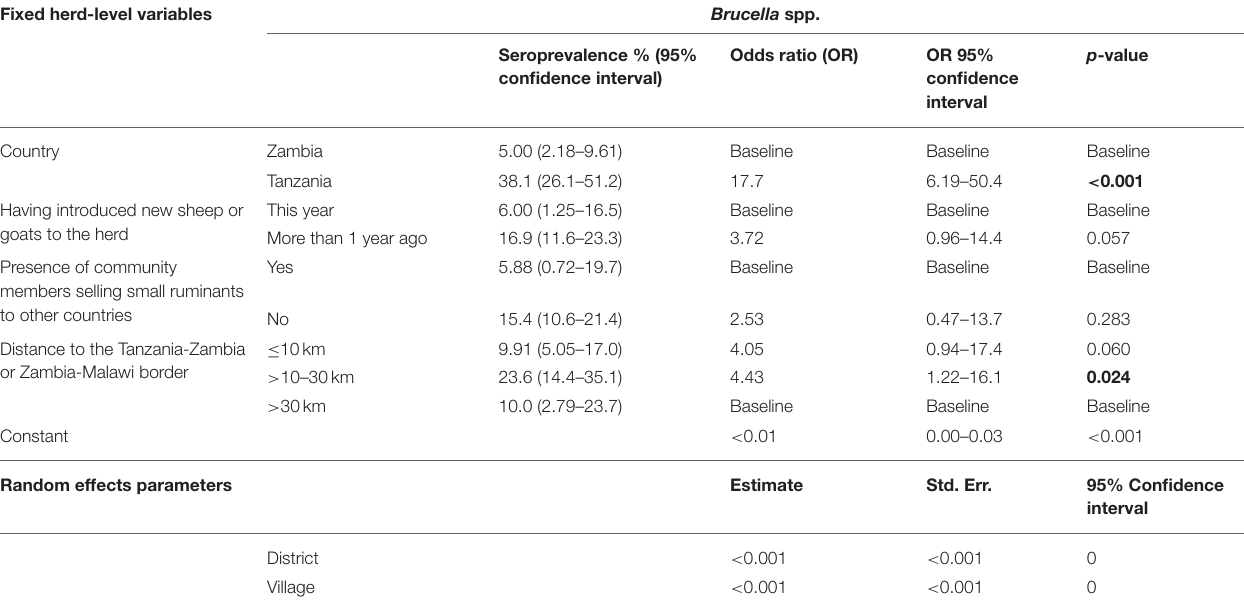
TABLE 12 | Predictor variables associated with herd-level seropositivity for Brucella